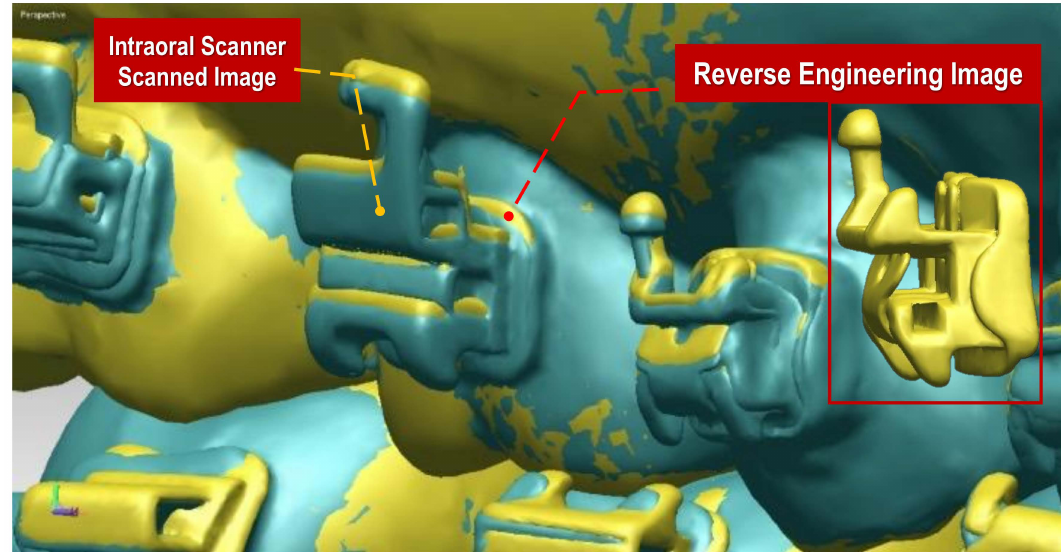
Figure 6. Three-dimensional digital superimposition (best-fit method) data. Combination between virtual model data with reverse engineering technique (yellow color) and intraoral scan data of post-transfer model (green color) using Rapidform software 2006 (INUS technology, Seoul, Korea).